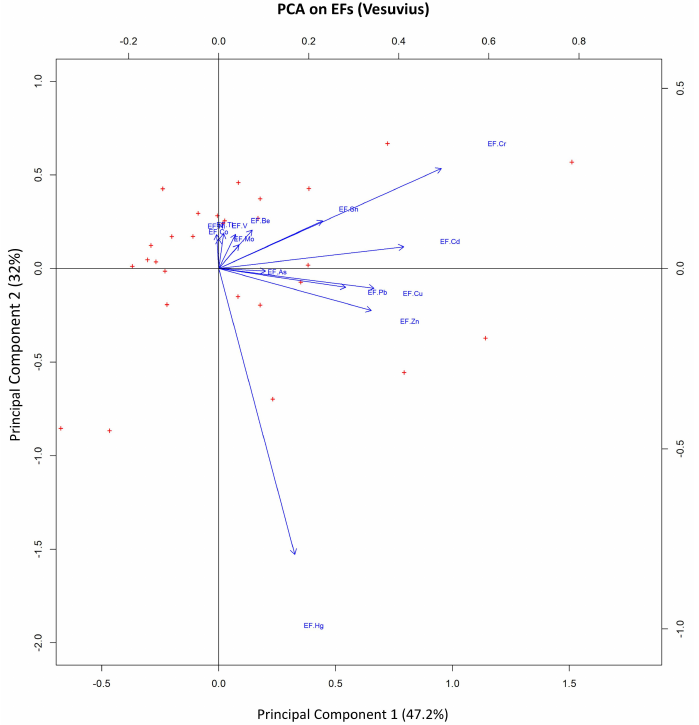
Figure 8. Figure 8. Biplots of PC1 vs. PC2. Observations (samples) are reported as red “+”, and the magnitude of the vectors (blue arrow) shows the strength of their contribution to each PC. Vectors pointing in similar directions indicate positively correlated variables, vectors pointing in opposite directions indicate negatively correlated variables, and vectors at approximately right angles indicate low or no